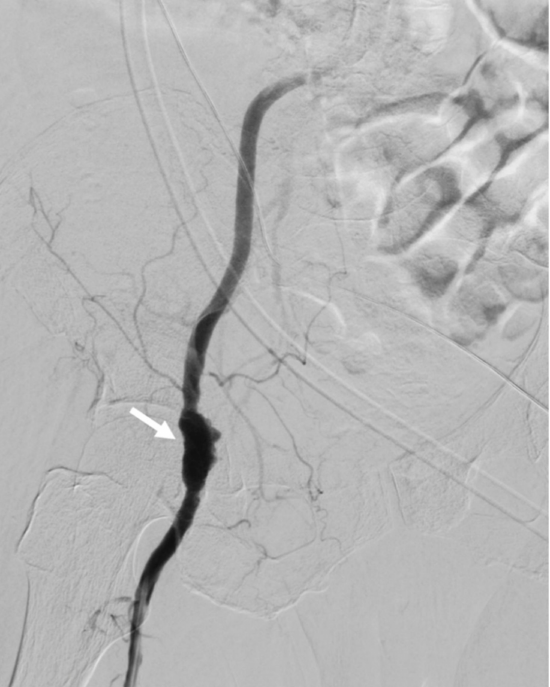
Figure 3. Angiography revealed right femoral artery, irregular-shape lesion (arrow)with infection. No contrast extravasation due to hematoma compression